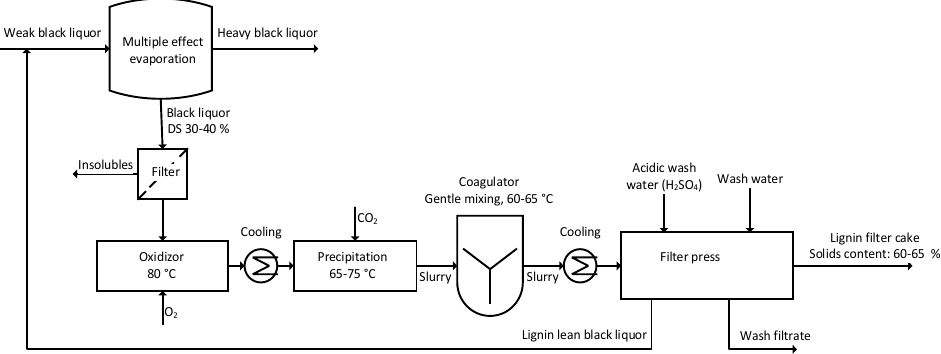
Figure 4. Schematic drawing of the LignoForce process.